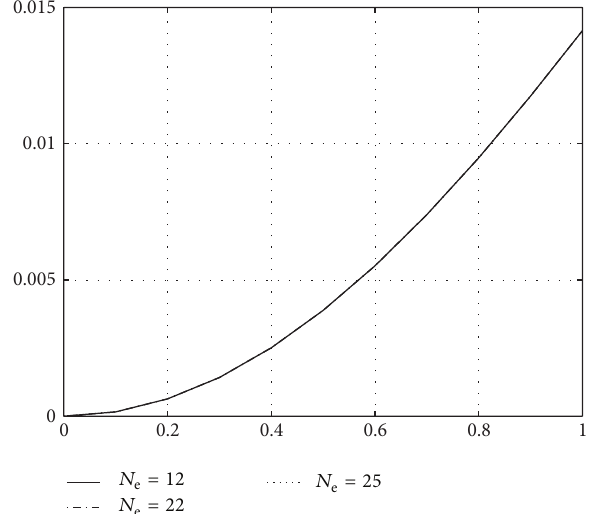
Figure 8: Numerical and exact solution of Example 7 for 𝑁 = 12 , 22 , 25